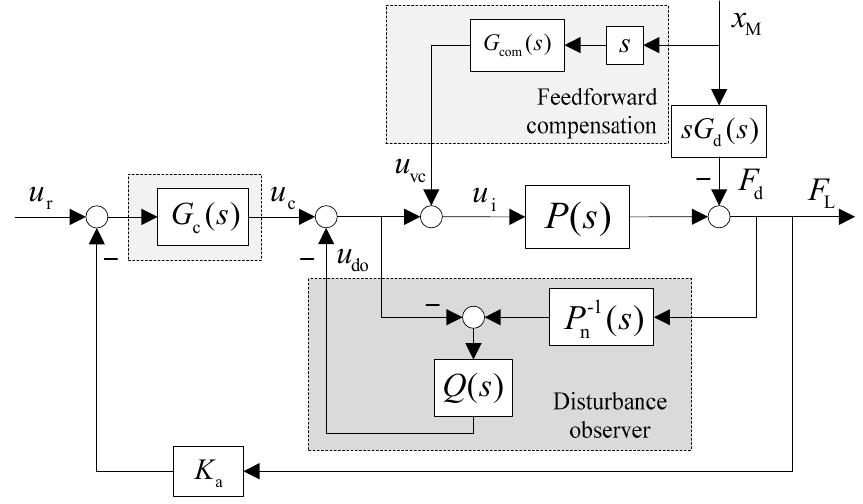
Figure 9. Schematic diagram of the hybrid control scheme for the loading system.